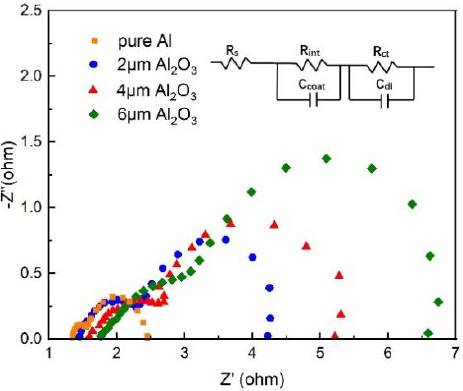
Figure 5. Nyquist plots of the Al anode modified by Al 2 O 3 interlayers of different thickness. Table 1. The resistance values of the equivalent circuit elements based on electrochemical impedance spectroscopy (EIS) measurements of Al–air batteries (The % errors are mentioned with circuit elements).